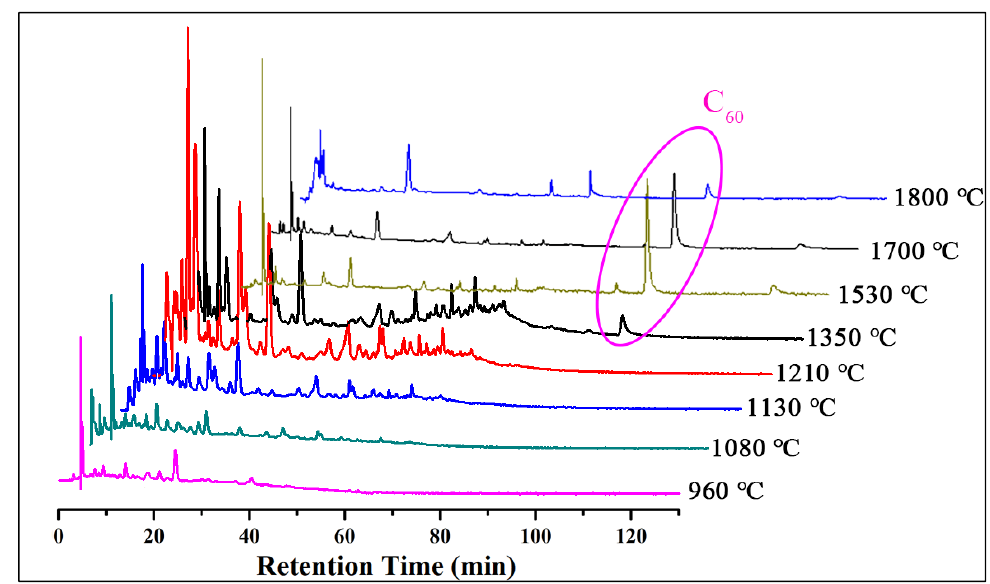
Figure 2. HPLC-UV (330 nm) chromatogram of the product from the pyrolysis of CHCl 3 at the temperature range of ~960 − 1800 ° C.